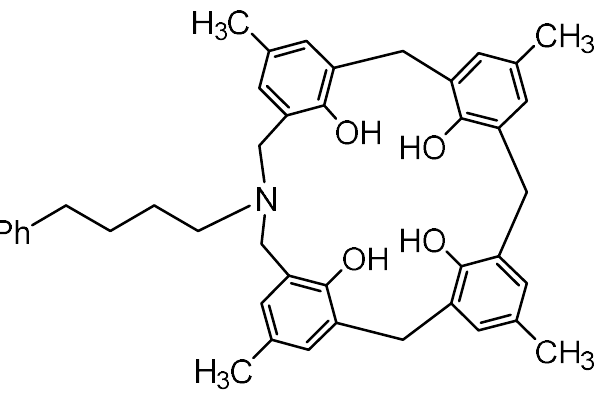
Figure 14. Design of p -methyl- N -(4-phenylbutyl)azacalix[3.1.1.1]arene. Theoretical calculations indicate that the origin of this interaction is the dispersion force [84–87]. Although the CH ··· π interaction is a weak interaction, (4–14 kJ mol − 1 ) [88–94], it can become non-negligible if many interactions are active at the same time [95–97]. Unlike interactions such as charge–charge and charge–dipole, the dispersion force is not affected by the polarity of the surrounding environment and can be observed both in solution and in solids. Therefore, it was inferred that the CH ··· π interaction is observed in the system of 8 (X = Me, R = (CH 2 ) 4 Ph) both in solution and in the solid-state. Since the side chains of the N -benzyl- and N -picolyl-azacalix[3.1.1.1]arene derivatives were located outside the ring structure, the author expected that the phenylbutyl group was also located outside the molecule ( exo type). In fact, however, in the crystal structure, the phenylbutyl group was incorporated into the molecular cavity ( endo type), and five of the eight hydrogens of the butyl group interacted with the aromatic ring forming the ring structure (CH ··· π interaction). In addition, one hydrogen of the benzene ring at the end of the phenylbutyl group was close to that of the π -plane of another molecule, where CH(Ar) ··· π interactions were also at work. In the crystal, a chain of CH(Ar) ··· π interactions was formed, and a CH(Ar) ··· π supramolecular structure was observed (Figure 15). In solution, the exo (cid:214) endo equilibrium of the phenylbutyl group due to the CH ··· π interaction was found to be established by temperature-variable NMR from 25 to − 60 ◦ C. In addition, H-HCOSY was measured at − 20 ◦ C, and the signals of the exo and endo forms were assigned. This produced the ratio of the two isomers at each temperature and the Gibbs energy change for this interconversion, ∆ G (273 K) = − 3.1 kJmol − 1 ( ∆ H = − 6.5 kJmol − 1 , ∆ S = − 35 Jmol − 1 ). In solution, the endo-conformer was the minor component, and the exo -form was the major component. In the solid-state, it is the endo - conformer as the stabilization of the CH ··· π interaction overcomes the thermal